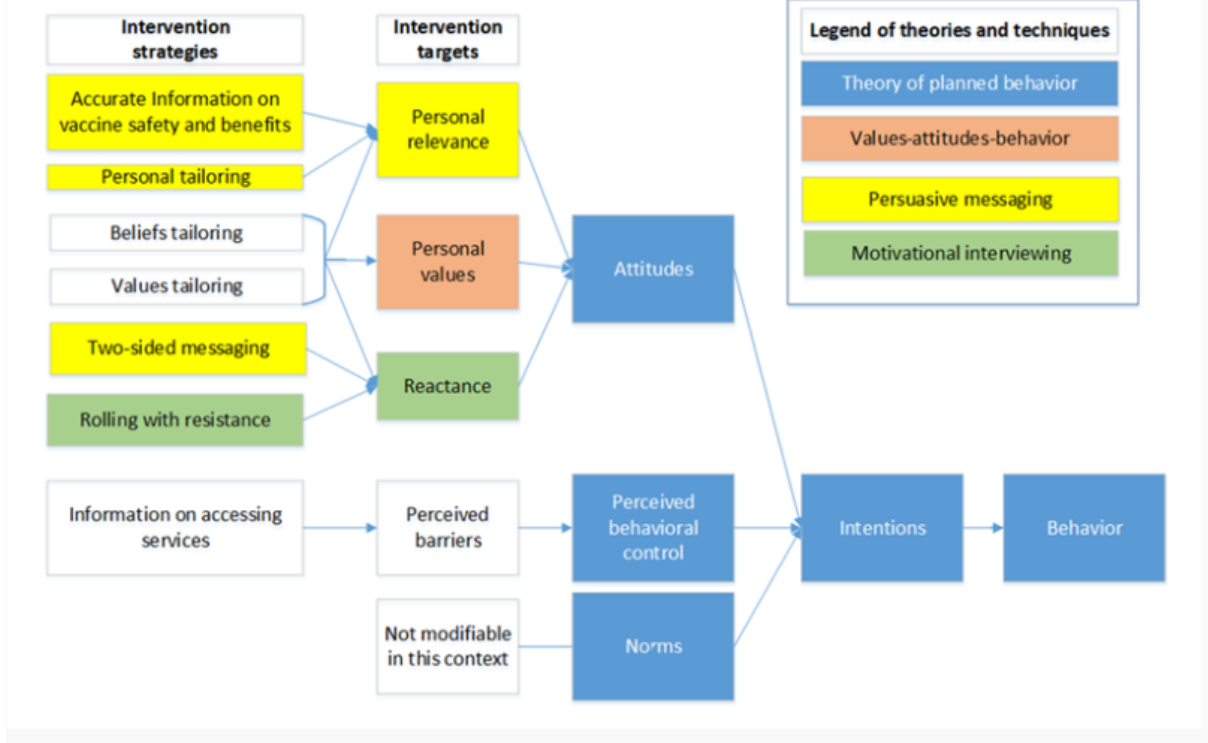
Figure 1. Conceptual model for a tailored messaging intervention to promote childhood